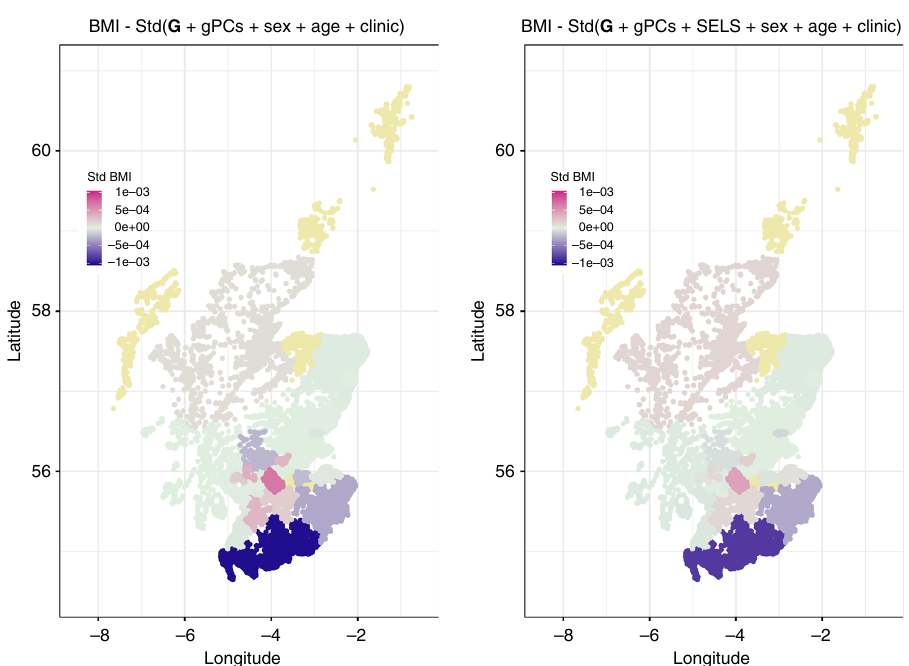
Fig. 2 Regional values of BMI before and after adjusting for the environmental variables. Changes in the standardised means of BMI per region before ( left panel ) and after ( right panel ) adjusting for all the lifestyle and socioeconomic covariates. Yellow : regions with less than 20 individuals, not